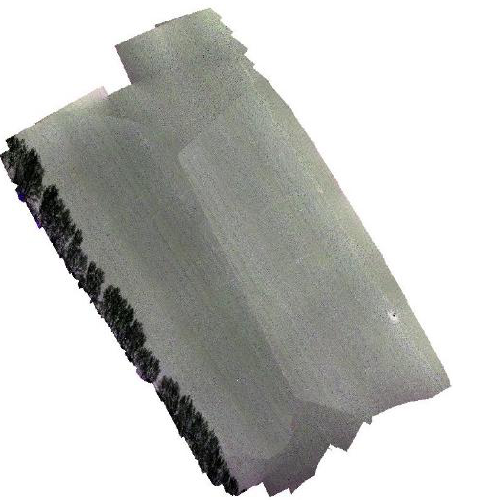
Figure 3. NIR-RG orthophoto of bare soil, computed with Pix4D and mosaicked in ArcGIS